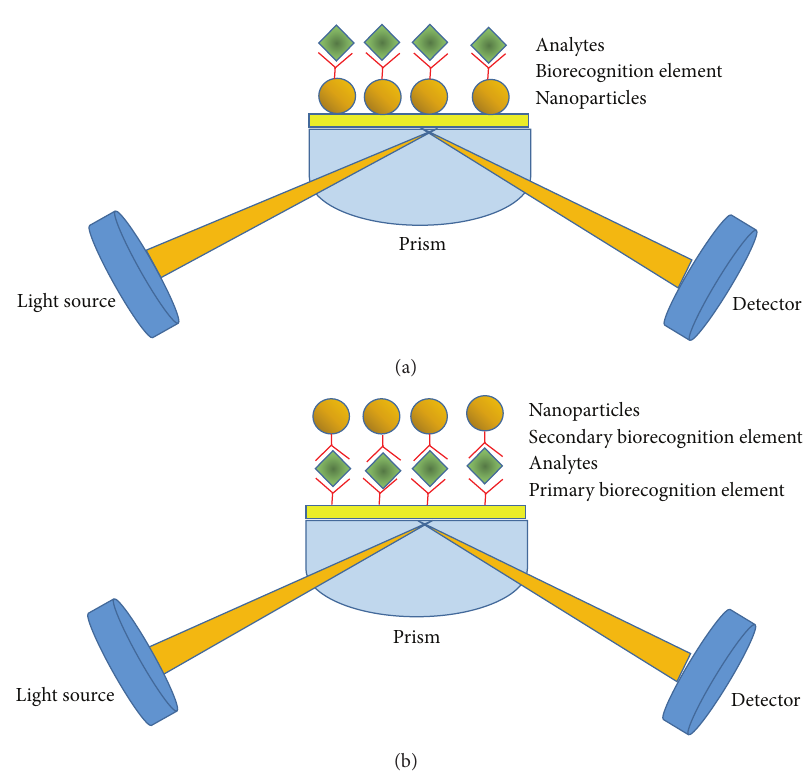
Figure 1: Scheme of bulk SPR with (a) nanoparticles incorporated onto the surface and (b) sandwich “assay” with nanoparticles amplification.